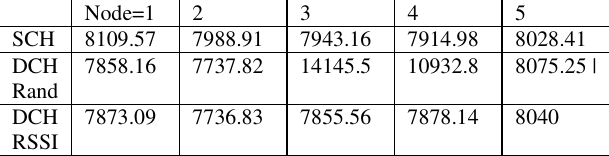
Table 5: Comparison of energy efficiency (nJoules/bit) Node=1 2